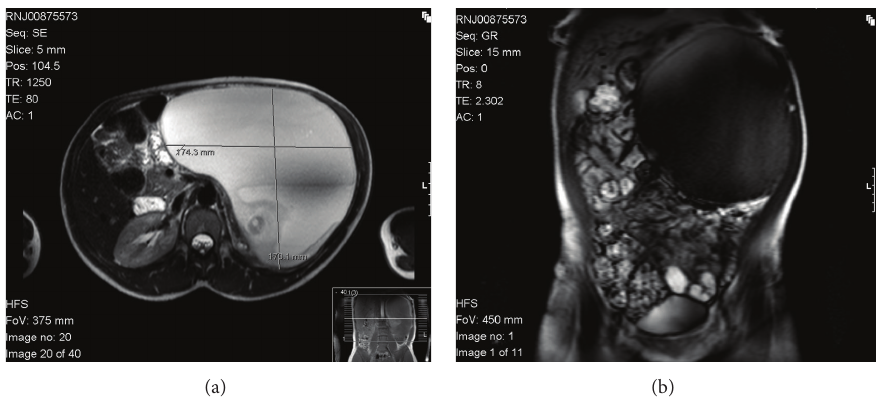
Figure 2: MRI images of the giant left retroperitoneal teratoma: (a) cross-sectional view and (b) coronal